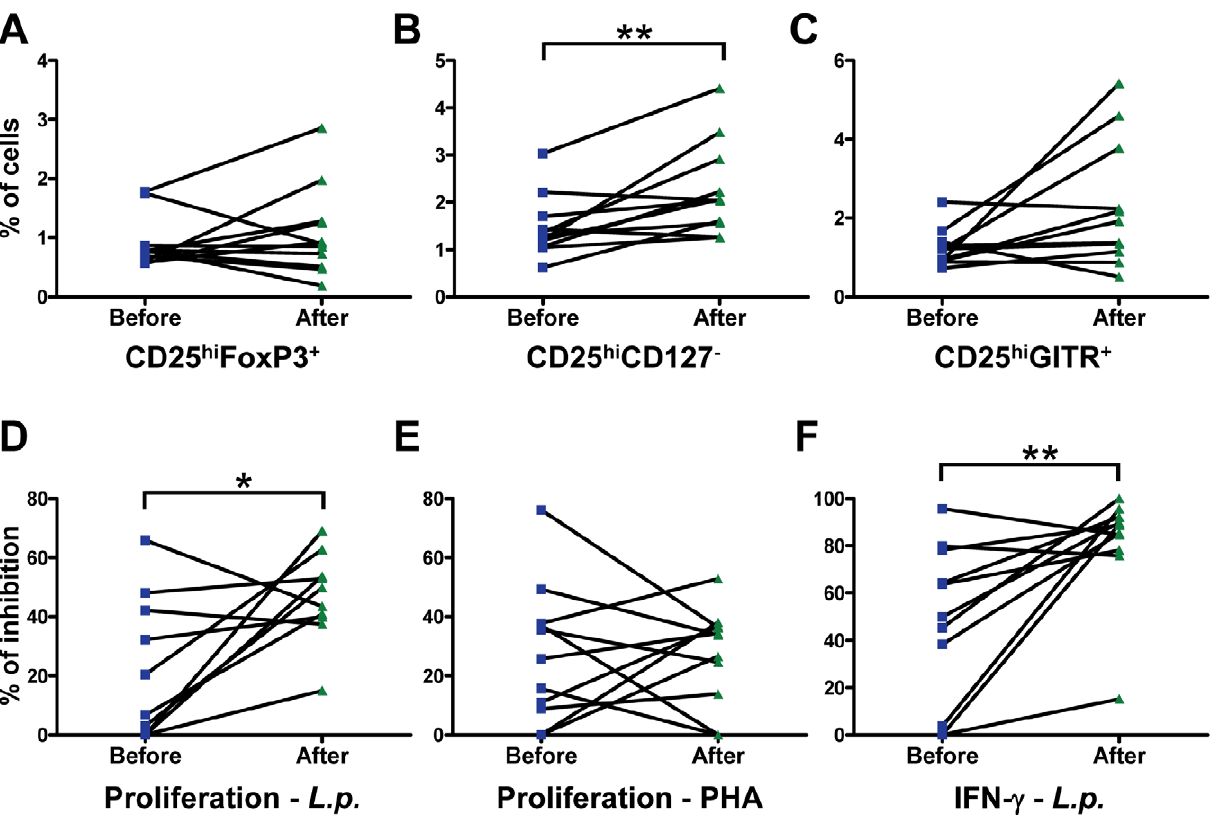
Figure 4. Treg frequency and function increase after treatment of CDL. Frequency of cells with a Treg phenotype in PBMCs and suppressive capacity of CD4 + CD25 + cells were determined for CDL patients (n=11) before and after treatment. A . Frequency of CD4 + CD25 hi Foxp3 + cells. B . Frequency of CD4 + CD25 hi CD127 2 cells. C . Frequency of CD4 + CD25 hi GITR + cells. D . Inhibition of CD4 + CD25 2 cell proliferation by CD4 + CD25 + cells at a 1:1 ratio after stimulation with L. panamensis (L.p.) and APCs. E . Inhibition of CD4 + CD25 2 cell proliferation by CD4 + CD25 + cells at a 4:1 ratio after stimulation with PHA. F . Inhibition of CD4 + CD25 2 cell IFN- c secretion by CD4 + CD25 + cells at a 1:1 ratio after stimulation with L.p. and APCs. Inhibition was calculated only for subjects that had proliferation and IFN- c levels above the average + 2SD of control wells from the same co-culture (n=10 for proliferation and 11 for IFN- c secretion with L.p. stimulation and n=11 for PHA stimulation). *p , 0.05, paired t-test, **p , 0.01, Wilcoxon signed-rank